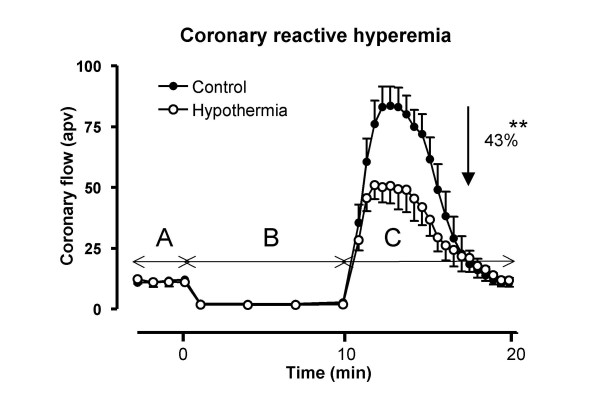
Coronary reactive hyperemia. The figure illustrates coronary blood flow expressed as average peak velocity (APV), in cm/s, in the LAD at baseline samples (A), at samples during the LAD occlusion (ischemia) (B), and at 10 sec intervals during the time of the reperfusion period (C), i.e., the phase of post-ischemic reactive hyperemia. The hypothermic group (n = 8) had a significant 43% lower peak flow than the normothermic group (n = 8) during the period of reactive hyperemia. There was no observed difference in coronary flow between the groups during baseline or after 7 minutes from reperfusion.